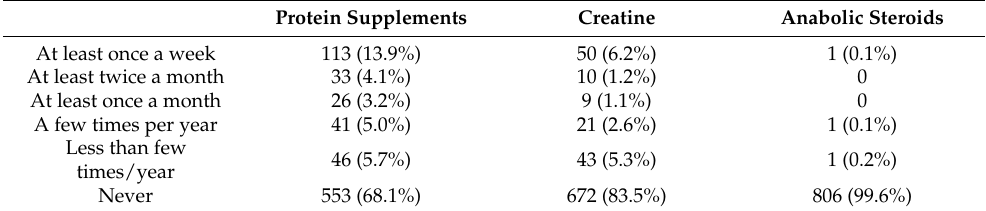
Table 1. The reported frequency and percentage of use of protein supplements, creatine, and anabolic steroids. Protein